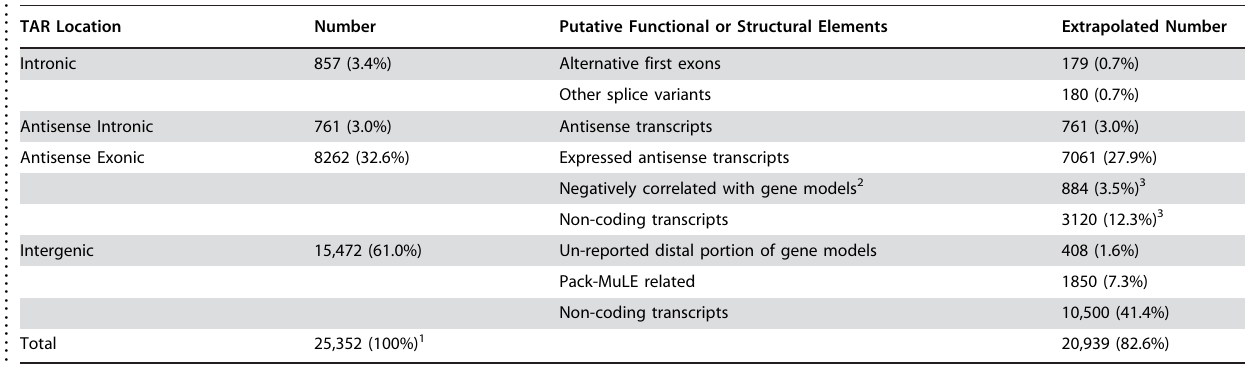
Table 1. Summary of characterization of non-exonic TARs in japonica rice. .. ... .... ... ... .... ... ... .... ... ... .... ... ... .... ... ... .... ... ... .... ... ... .... ... ... .... ... ... .... ... ... .... ... ... .... ... ... .... ... ... .... ... ... . TAR